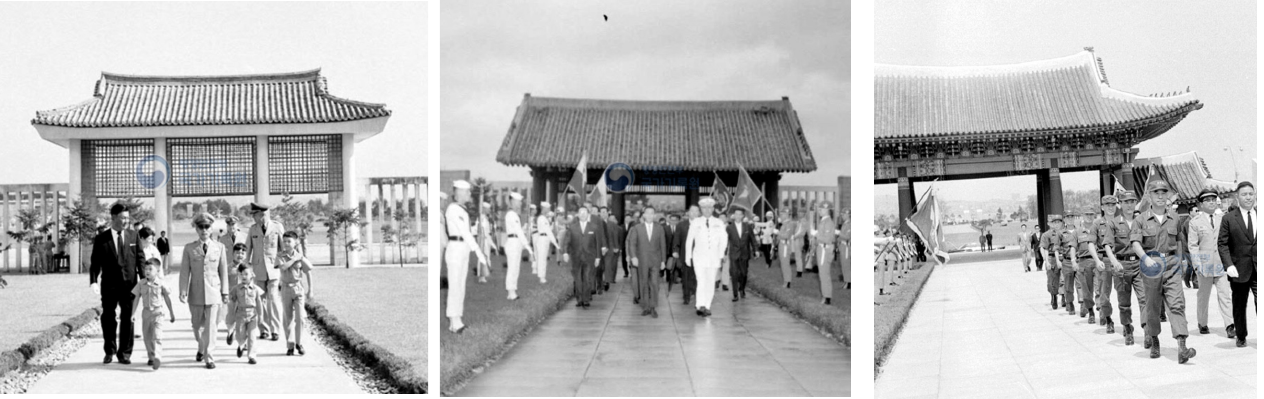
Figure 7. Chronological Changes in the Main Entrance’s Roof of Seoul National Cemetery (Photographs Taken in 1961, 1966, and 1969; source: National Archives of Korea).